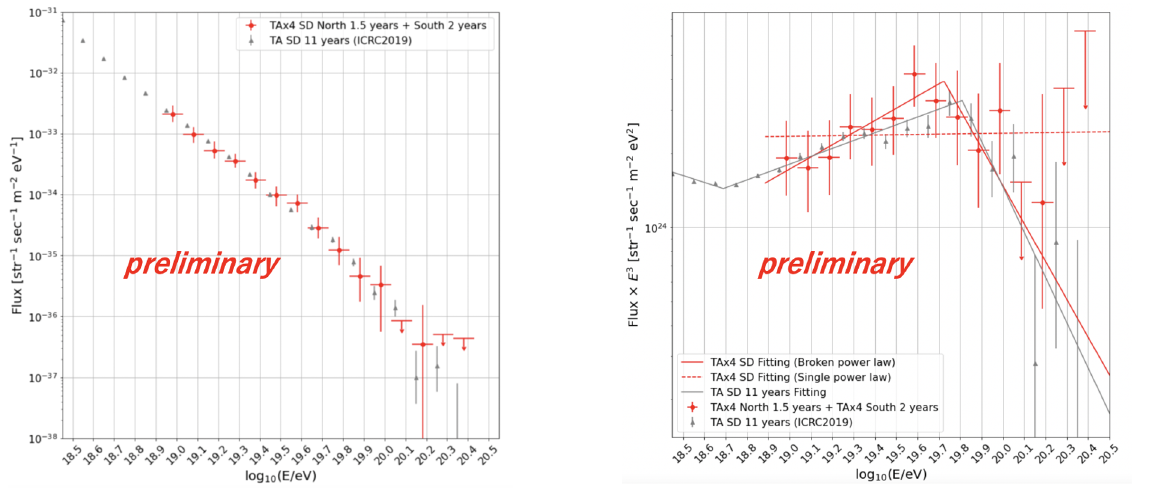
Figure 5: The energy spectrum observed by TAx4 SD array is shown by the red points. The TA SD 11 years energy spectrum [11] is also shown in gray points for comparison. The energy scaling factor between the FD and the SD is assumed to be 1.3. The statistical uncertainty according to [13] of the observed events is considered in the TAx4 SD energy spectrum. For 0 events-observed energy bins, 90% upper limits are shown. The energy spectra, multiplied by E 3 , are shown in the right figure. The red solid line and the red dashed line in the right figure are the fits with broken power law function and single power law function